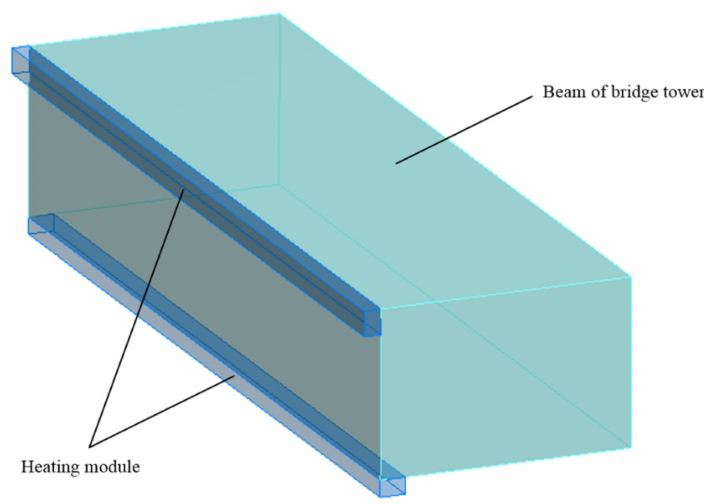
Figure 15. Schematic diagram of heating module